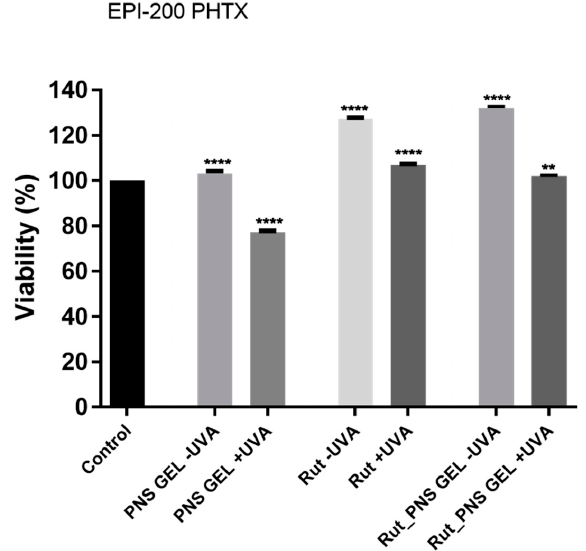
Figure 7. Viability percentage of EpiDerm skin model inserts (EPI-200 PHTX) at 24 h posttreatment with the test samples (proniosomal control gel, rutin and proniosomal rutin gel) ± UVA treatment. One-way analysis of variance (ANOVA) followed by Tukey’s post-test was employed to determine the statistical differences between sample-treated inserts and negative control-treated inserts ( p < 0.01, p < 0.0001 indicated by ** and ****). Sesame oil or Milli-Q H 2 O was used as a negative control.